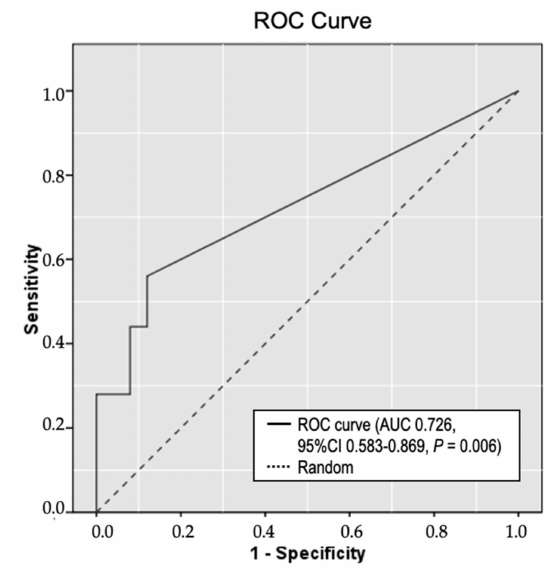
Figure 5. Receiver operating curve (ROC) analysis of circulating methylated RPRML DNA as a biomarker for detecting GC. Plasma samples from 25 GC cases and 25 age- and sex-balanced cancer-free controls were analyzed using the MethyLight assay. The solid line represents the ROC curve for circulating methylated RPRML DNA; the dashed line represents the line of no discrimination. The area under the curve (AUC) was 0.726 (95% confidence interval (CI): 0.583–0.869, p =